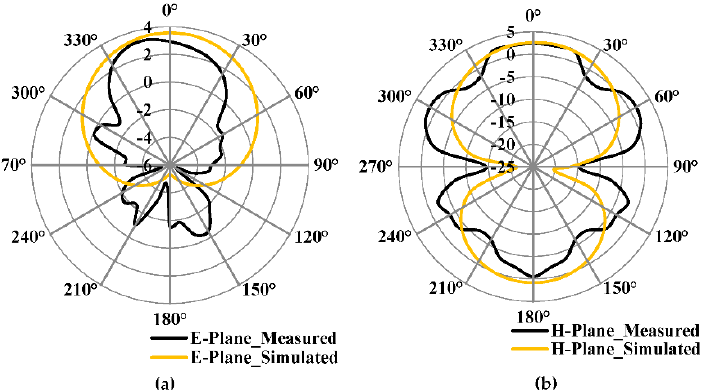
Figure 17. Simulated and Measured radiation pattern of the proposed antenna with complete ground plane ( a ) E-Plane ( b ) H-Plane.